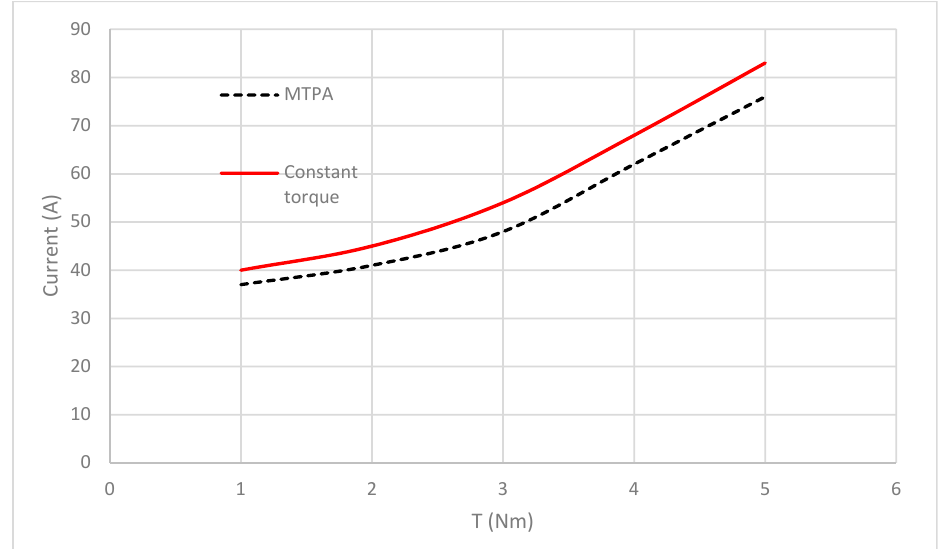
Figure 13. Curves of load vs current at 2000 rpm using a fixed torque angle and fuzzy MTPA control via HIL.